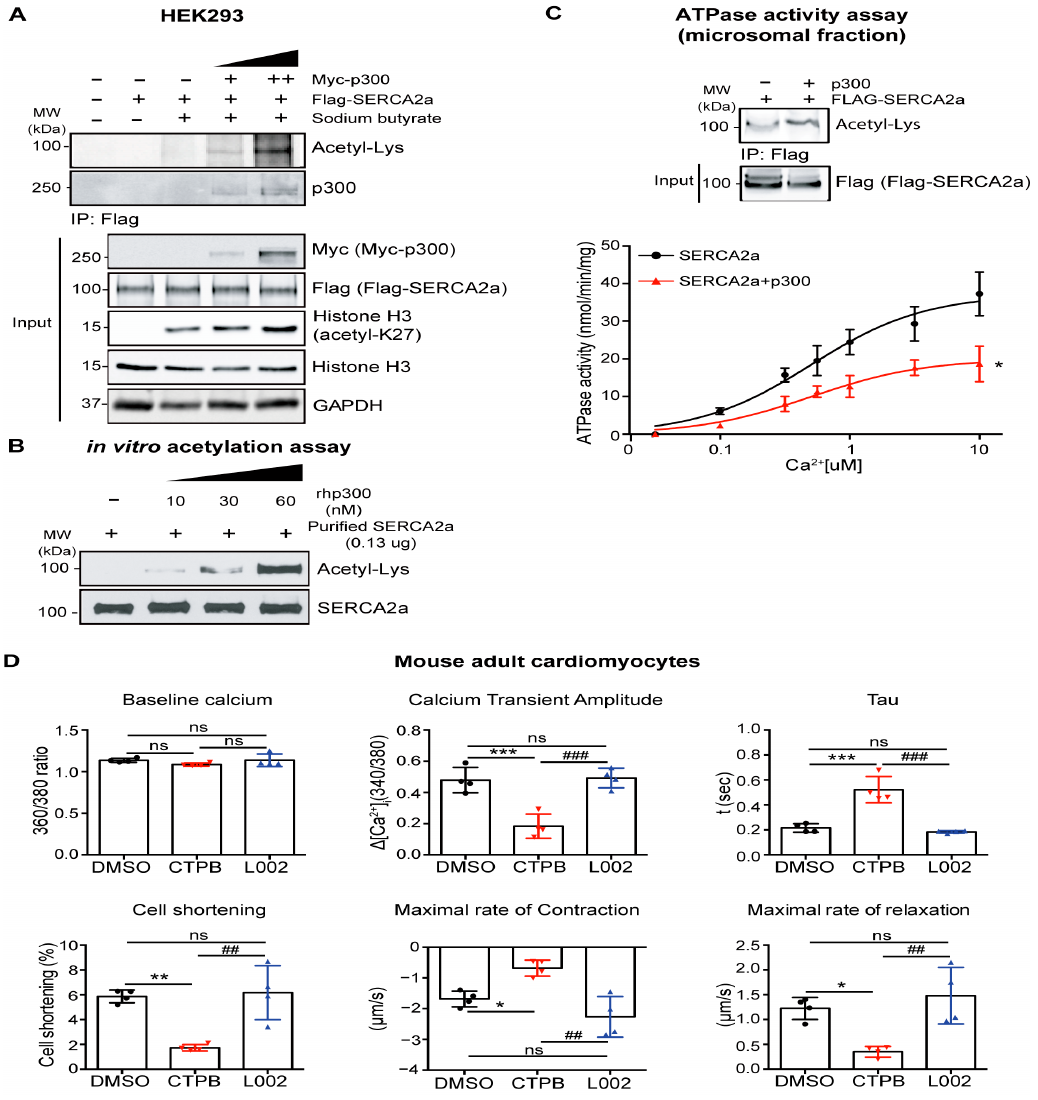
Figure 3. p300 acetylates SERCA2a and diminishes its activity. ( A ) HEK-293 cells were transfected with SERCA2a alone or SERCA2a in combination with different dosages of p300 plasmid. Anti-Flag agarose beads were incubated with lysates of these HEK293 cells. Sodium butyrate was treated to inhibit the deacetylation of SERCA2a. Immunoprecipitants were probed with anti-acetyl-lysine or anti-p300 antibodies. ( B ) SERCA2a protein was purified from normal pig hearts and incubated with recombinant human p300 (rhp300). The in vitro acetylation was probed with anti-acetyl-lysine and anti-SERCA2a antibodies. ( C ) Calcium-dependent ATPase activity was measured using microsomal fractions isolated from HEK-293 cells expressing SERCA2a alone (black line) or SERCA2a and p300 (red line). Data are represented as the mean ± SD of n = 3. * p < 0.05 vs. SERCA2a alone by paired t -test. ( D ) Mouse adult cardiomyocytes (ACMs) were isolated from male C57BL/6J mice and treated with 5 μ M CTPB (p300 activator) or 5 μ M L002 (p300 inhibitor). 24 h after treatment with CTPB or L002, the contractile response of ACMs was assessed by calcium transient amplitude, decay time constant (tau), peak shortening, maximal rate of contraction, and maximal rate of relaxation using a video-based edge-detection system (IonOptix, Inc, Milton, MA, USA). Fifteen cardiomyocytes were measured per mouse, n = 4. Graphs show mean ± SD, with each data point represented by a mean average of 15 cardiomyocytes isolated from one heart sample. ns, not significant; * p < 0.05; ** p < 0.01; *** p < 0.001 vs. DMSO-treated ACMs and ## p < 0.01; ### p < 0.001 vs. CTPB-treated ACMs by one-way ANOVA.